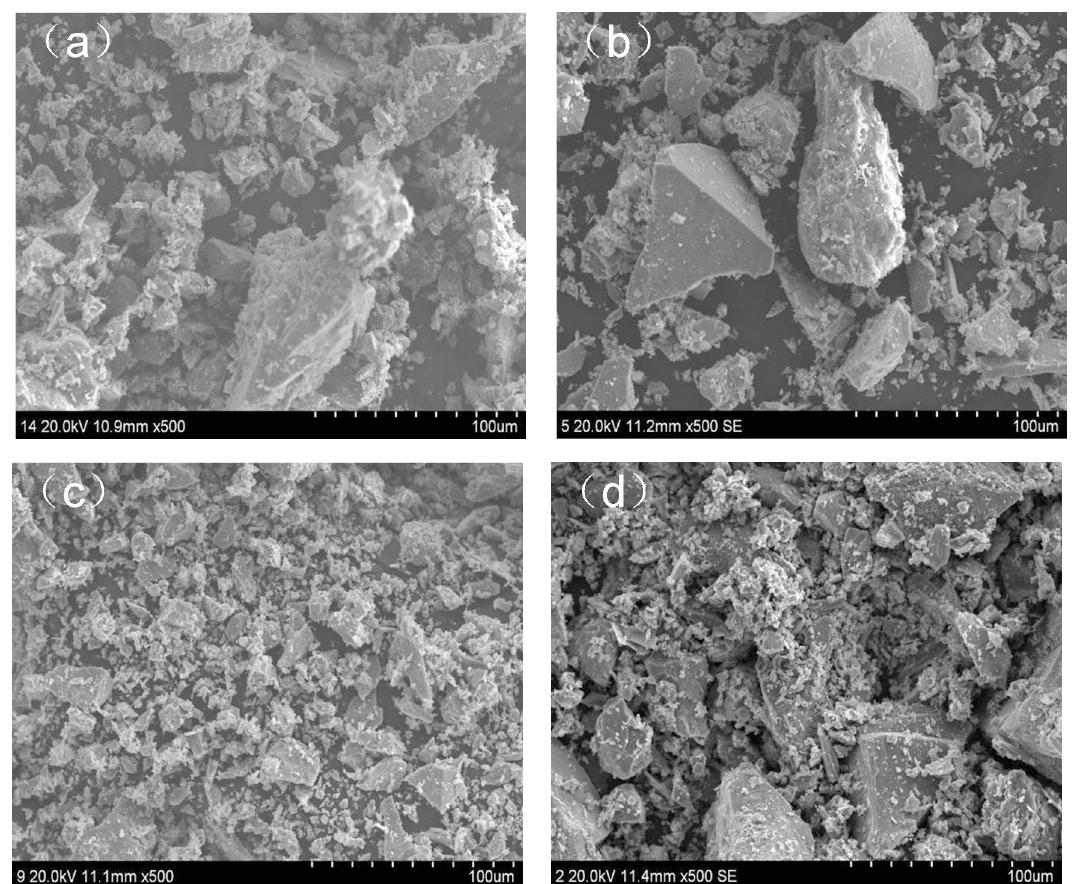
Figure 3. SEM Images of the four PVTM magnetite. ( a ) A ore; ( b ) B ore; ( c ) C ore; ( d ) D